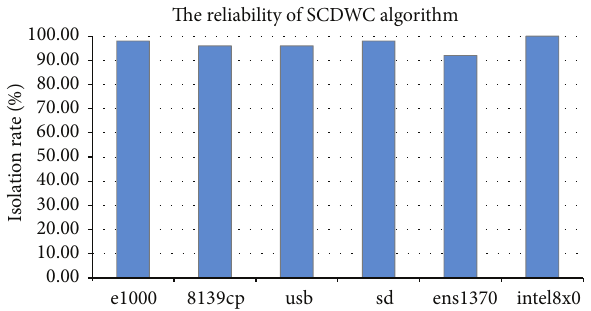
Figure 8: The reliability of Chariot after using SCDWC algorithm.